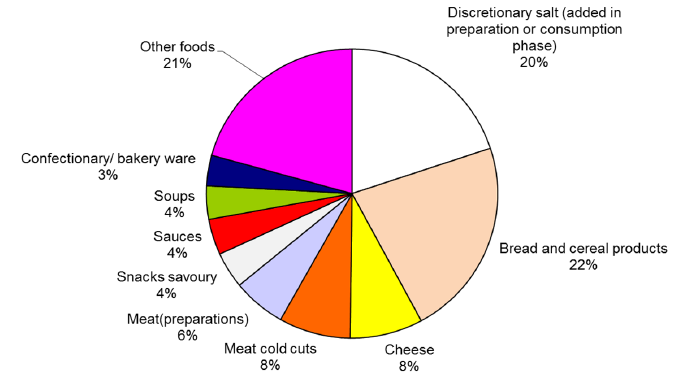
Figure 2. Food groups contributing to salt intake (including discretionary salt) in the Netherlands, food groups contributing more than 3% are included in this study.